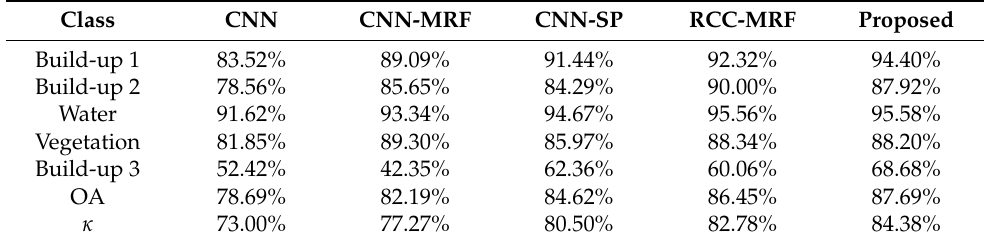
Table 5. Accuracies of classification on SF-Bay